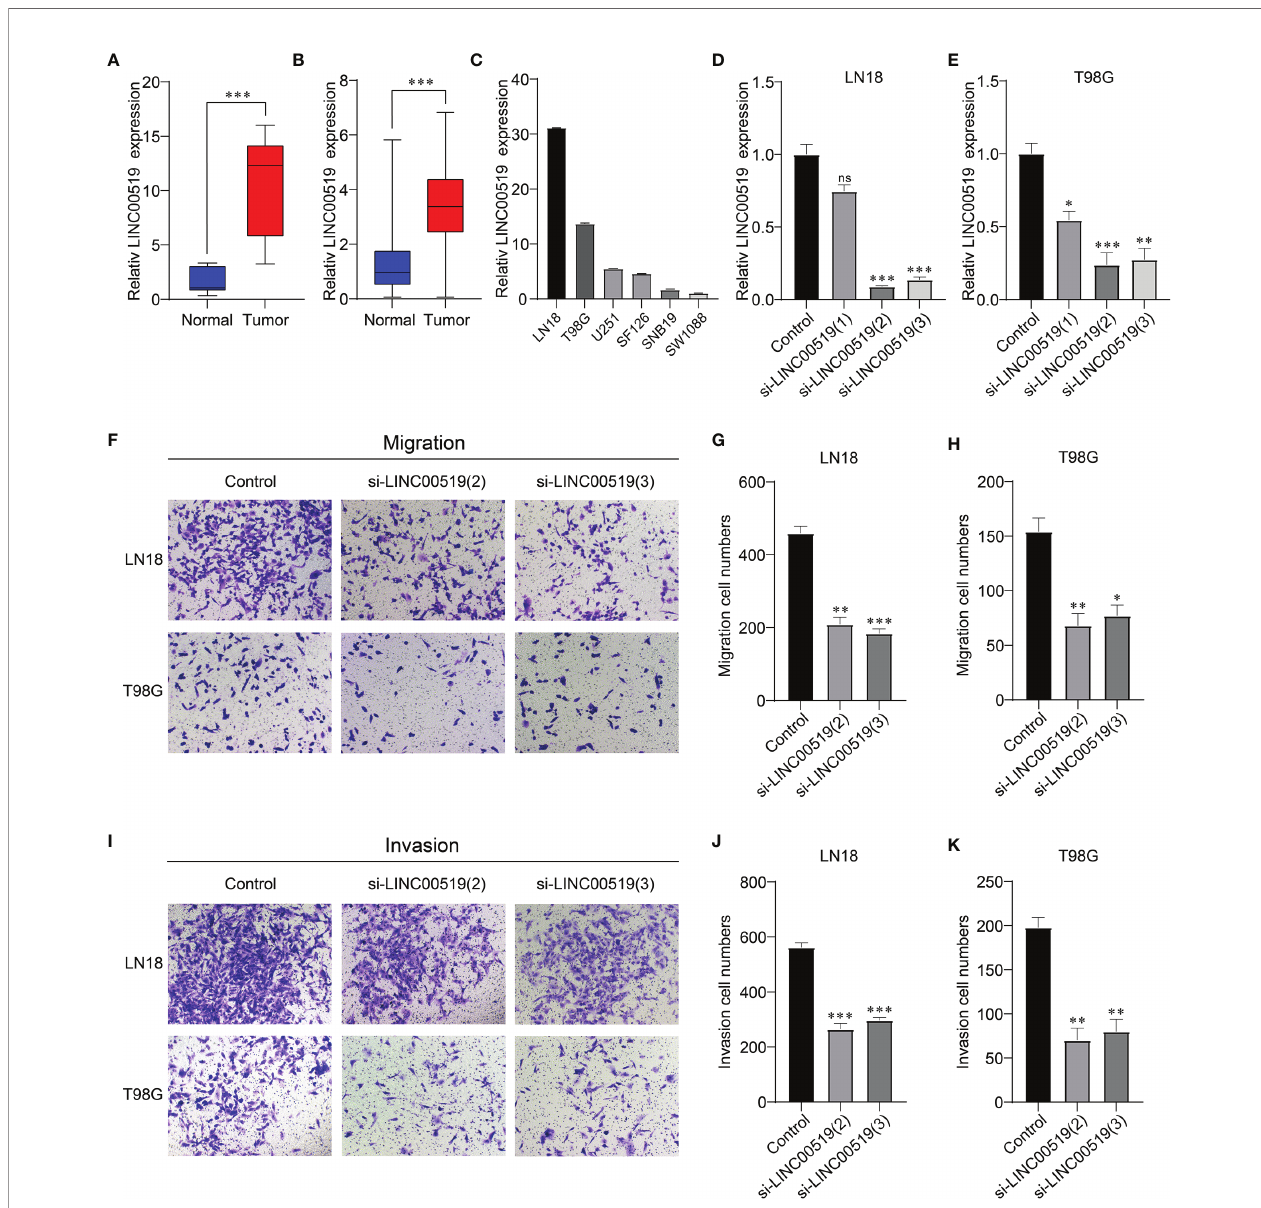
FIGURE 9 | Veri fi cation of the silencing effect. (A) Relative expression levels of LINC00519 in normal and glioma brain tissues from our cohort. (B) Relative expression levels of LINC00519 in normal and glioma tissues from GTEx (n=1132) and the TCGA database (n=689). (C) Relative expression of LINC00519 in six cell lines. (D, E) Detection of the relative silencing levels of LINC00519 in LN18 (D) and T98G (E) cells. (F – H) Representative imaging (F) or counting (G, H) of migration assays after silencing with LINC00519 in LN18 and T98G cells. (I-K) Representative imaging (I) or counting (J, K) of invasion assays after silencing with LINC00519 in LN18 and T98G cells. *p < 0.05, **p < 0.01, ***p < 0.001; NS, no signi fi